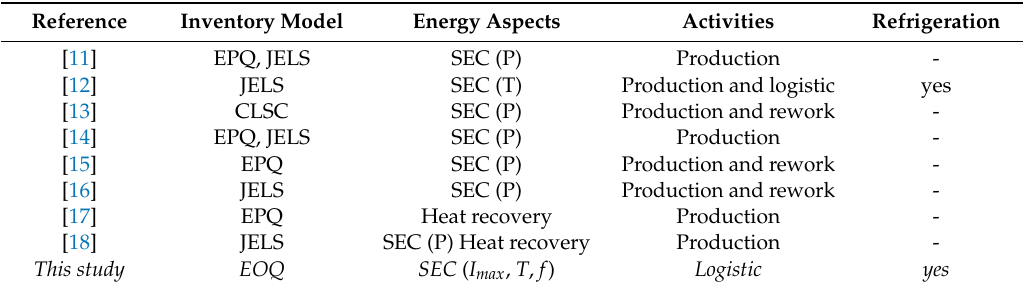
Table 1. Summary of related literature for inventory models with energy